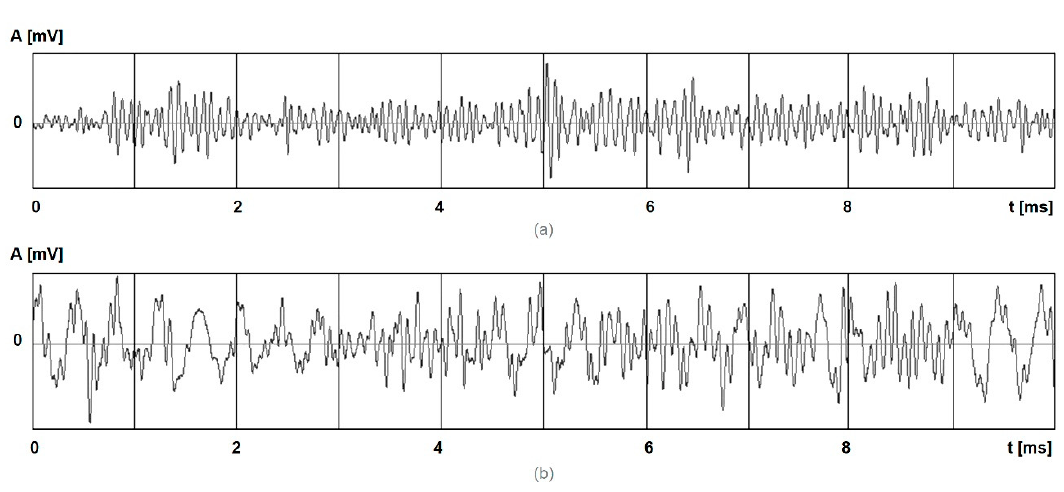
Figure 10. Vibroacoustic signals at 10 ms period during electrical discharge machining of M05 hard alloy: ( a ) is at the moment of wire approach; ( b ) is before wire break.